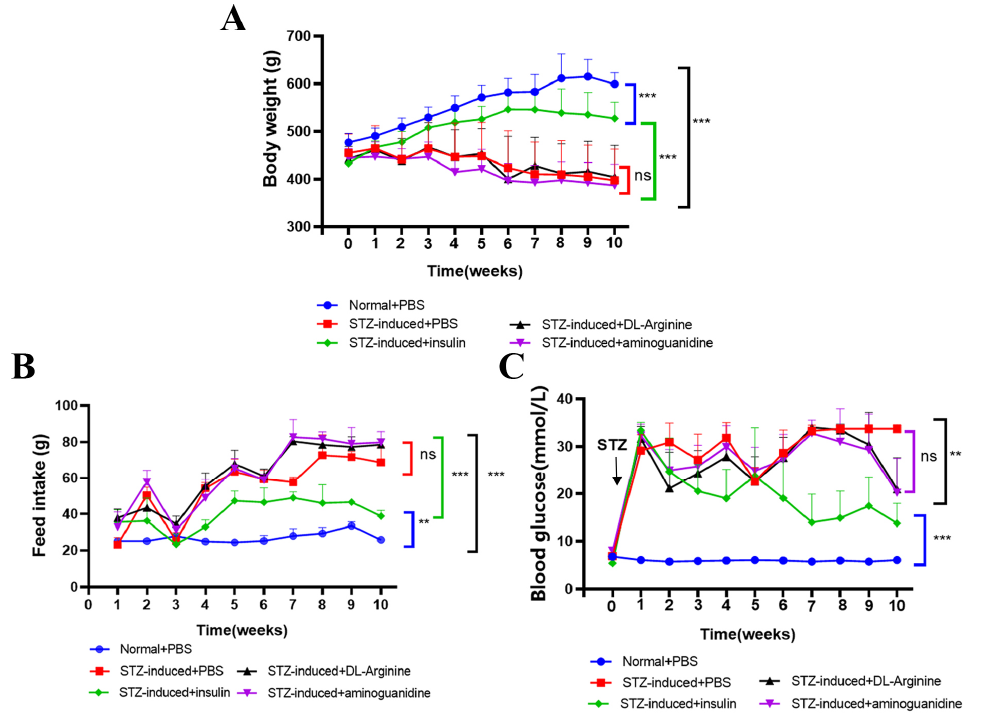
Figure 8. Effects of DL-arginine treatment on feed intake, body weight, and blood glucose of rats. ( A ) The body weight of each group was determined every week. ( B ) The feed intake of each group was determined every week. ( C ) Blood glucose levels of each group were after fasting for 3 h determined every week. All values of ( A – C ) are mean ± SE n = 6 rats per group, with ** p < 0.01, *** p < 0.001, determined by one-way ANOVA.